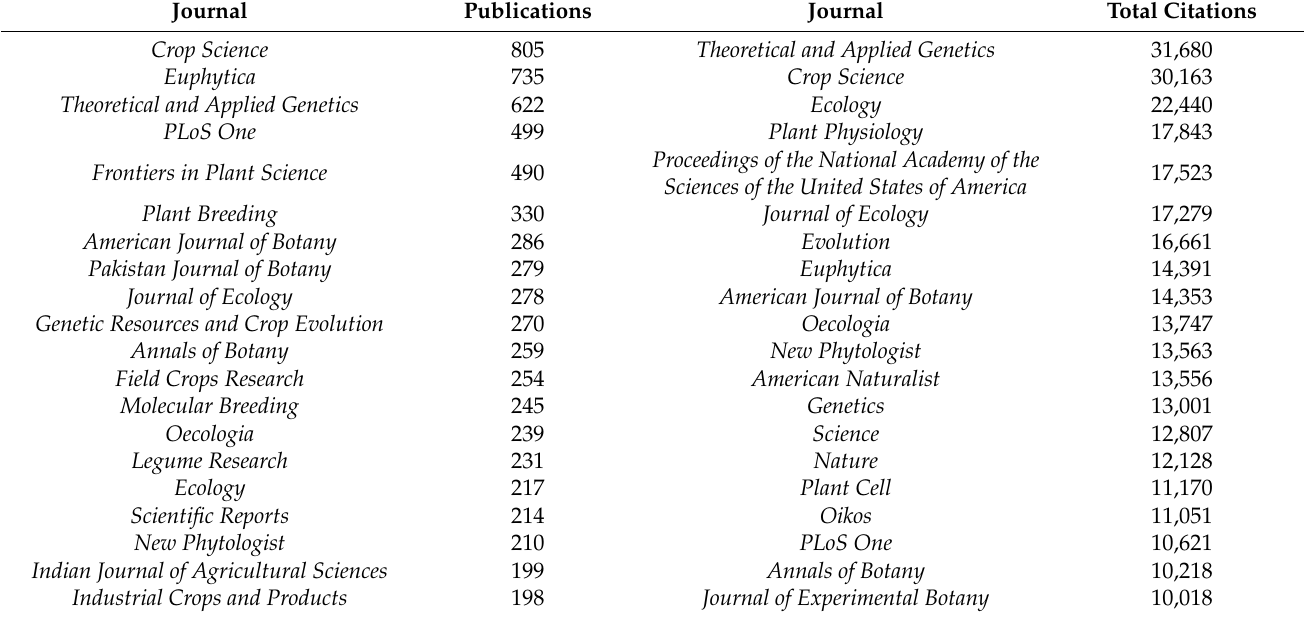
Table 2. Top 20 most marked and cited journals with the publications of seed traits (ST) during the period of